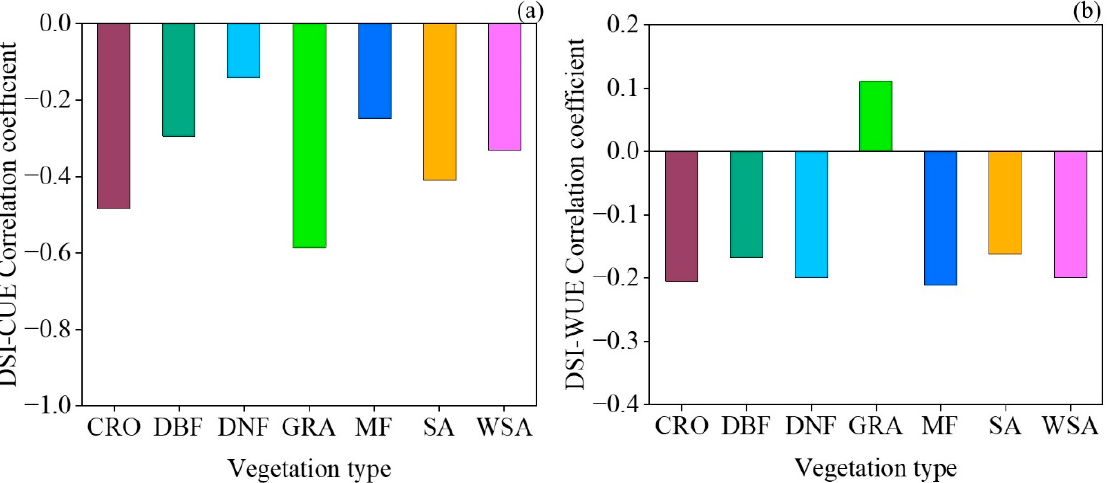
Figure 8. Correlation coefficients of CUE and WUE with DSI for different plant types in Inner Mongolia from 2001 to 2020. ( a ) Correlation coefficients of CUE and DSI; ( b ) correlation coefficients of WUE and DSI.